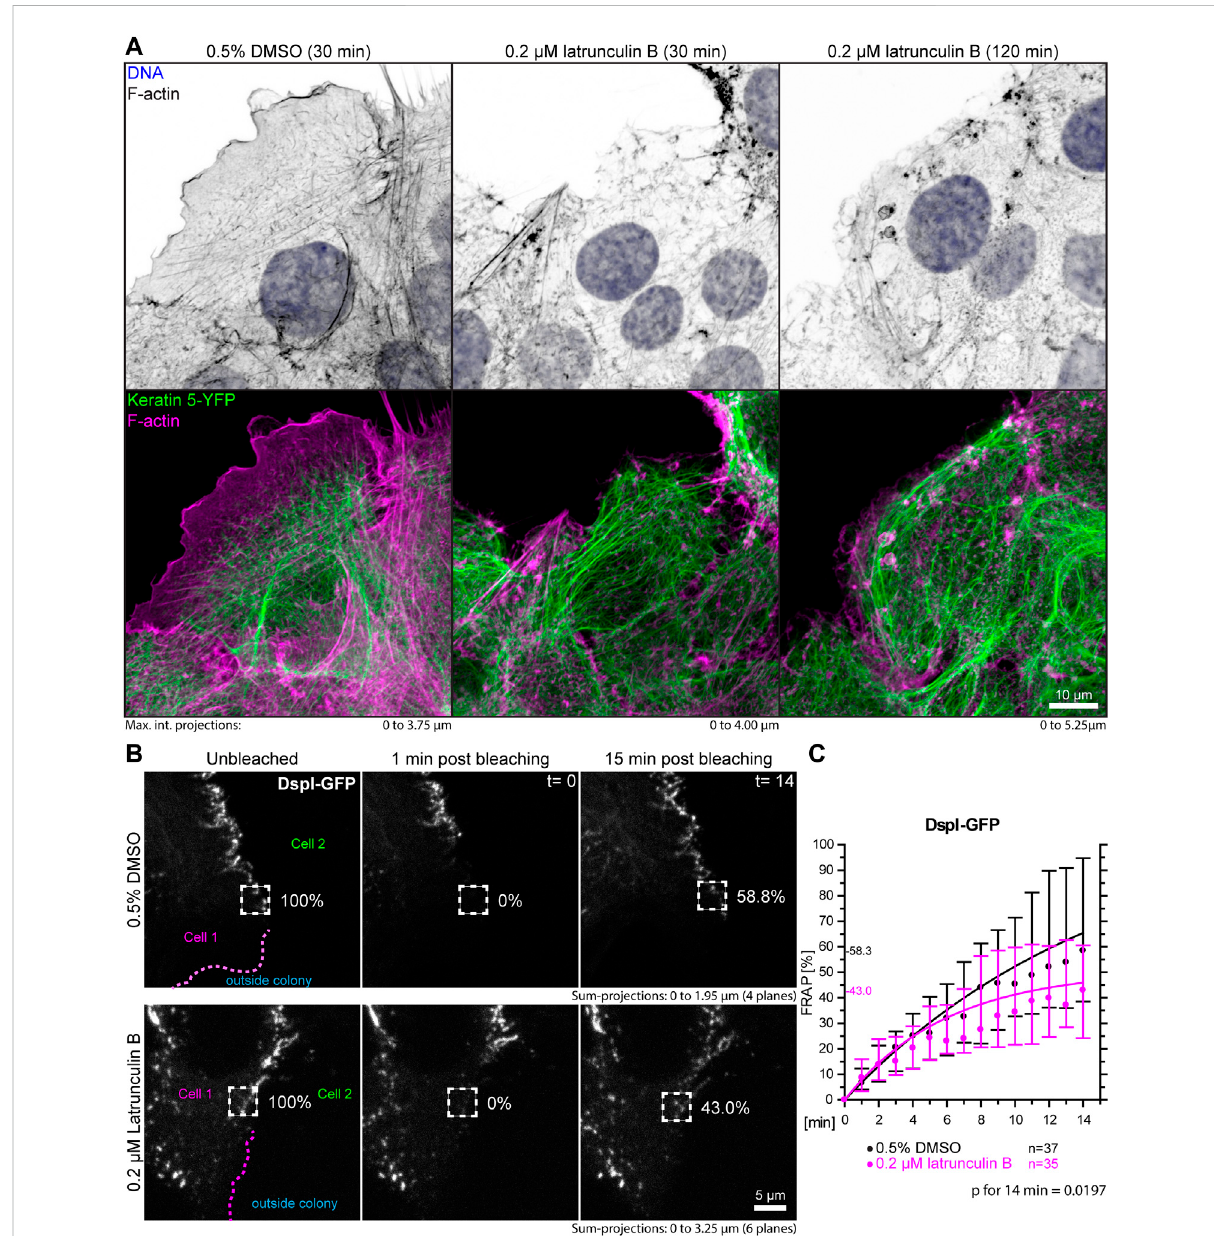
FIGURE 7 PartialdepolymerizationofF-actinreducesdesmosomalDspIturnover. (A) Theimagesshowmaximumintensityprojectionsof fl uorescencein fi xed HaCaT keratinocytes. Actin fi laments were stained with Alexa-647 tagged phalloidin (top panels) in HaCaT B10 cells that stably express keratin 5-YFP (composite images in bottom panel). The cells were incubated with control medium (0.5% DMSO; left) or 0.2 µM latrunculin B (middle and right). Note that the latrunculin B treatment leads to signi fi cant yet incomplete actin fi lament depletion. (B) shows the results of FRAP analyses. Sum-projectionsofconfocalDspI-GFP fl uorescencerecordingsareshownfromlefttorightjustpriortobleaching,1 minafterwardsandafter15 min incontrolcells(0.5%DMSO;top)andcellstreatedwith0.2%latrunculinBinaddition(bottom).Theregionsofinterestaredemarcatedbybrokenlines andtherelative fl uorescencemeasuredintheseregionsaregivenin%. (C) Thegraphdepictsthe fl uorescencerecoverycurvesofDspI-GFPfrom1to 15 min after photobleaching. Dots represent medians, whiskers correspond to the 25 – 75th percentiles, and statistical analysiswas performed with a Mann-Whitney test for the last time